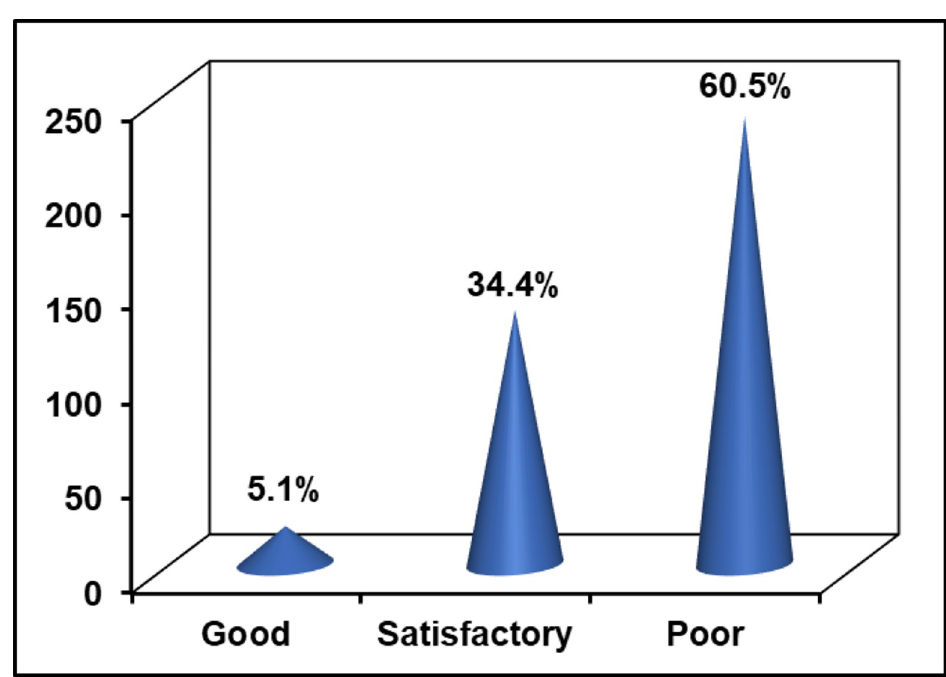
Fig 3. Household responses towards city government solid waste collection and disposal services.